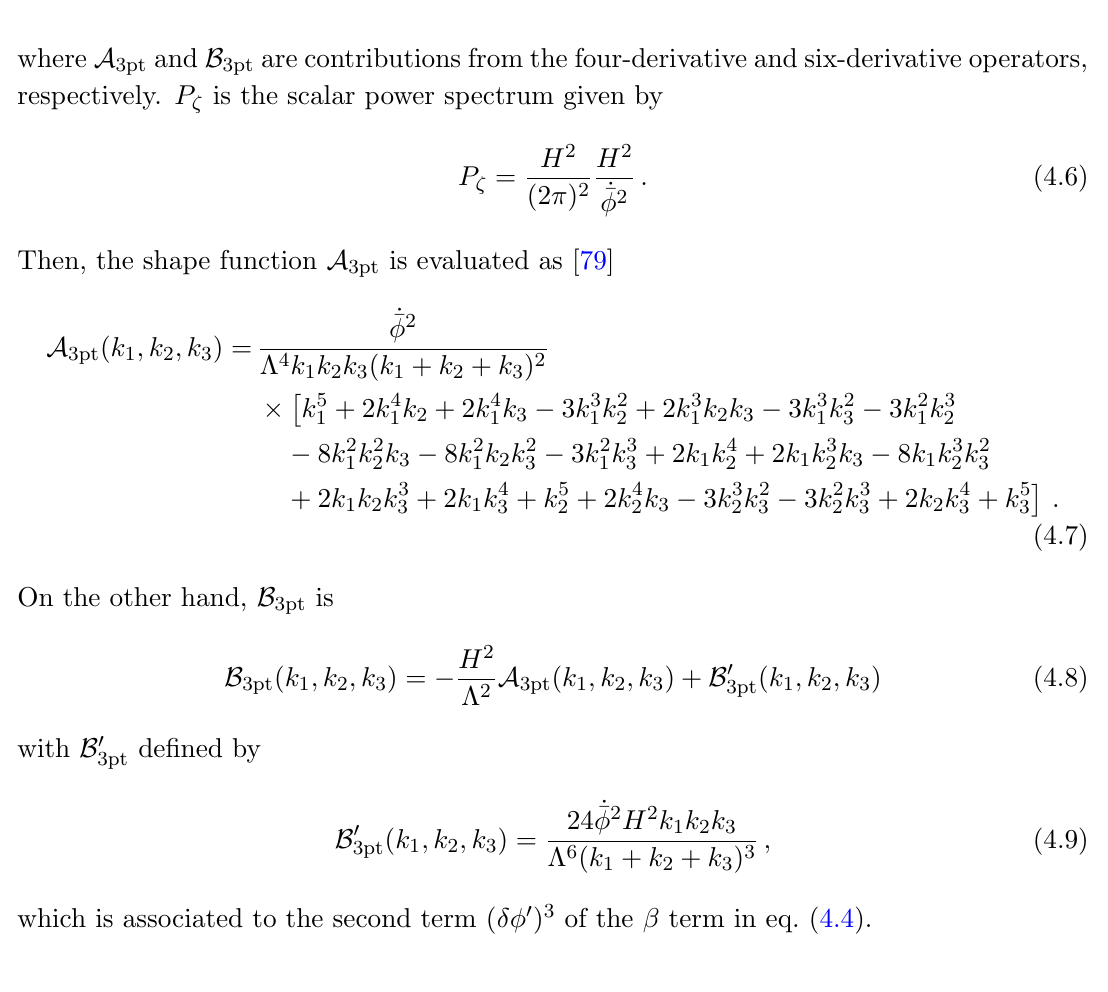
Figure 4 . Shape of A 3pt (left) and B 0 con(cid:12)guration k by a factor (cid:24)